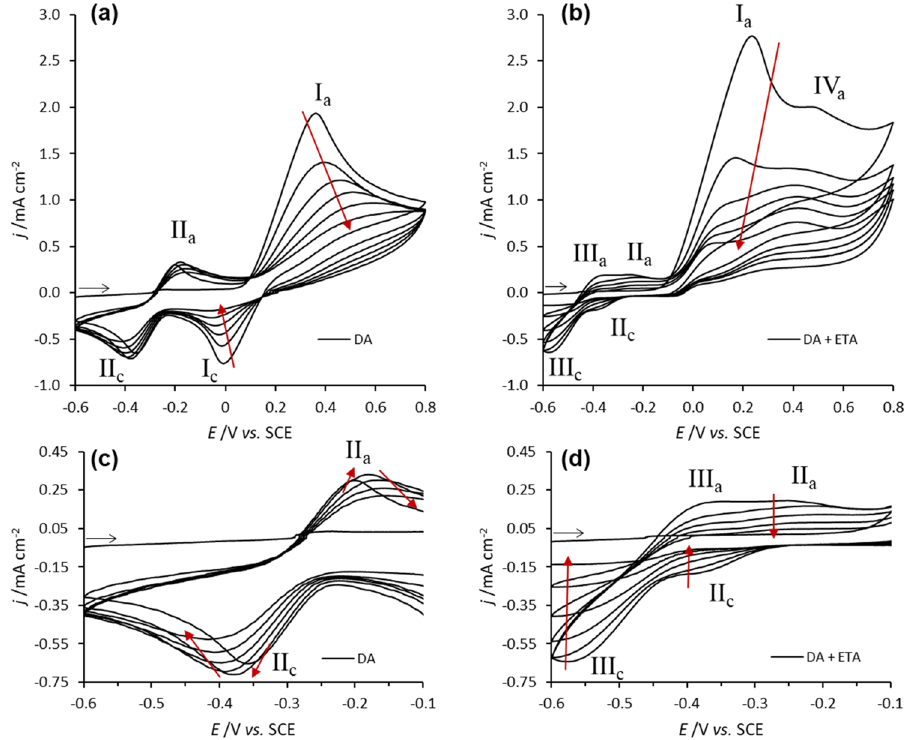
Figure 2. Potentiodynamic polymerization of 5 mM dopamine in the absence ( a ) and presence ( b ) of 100 mM ethanolamine, carried out at 200 mV s −1 for 6 potential cycles in deoxygenated CPB. Cyclic voltammograms ( c ) and ( d ) are amplifications of ( a ) and ( b )